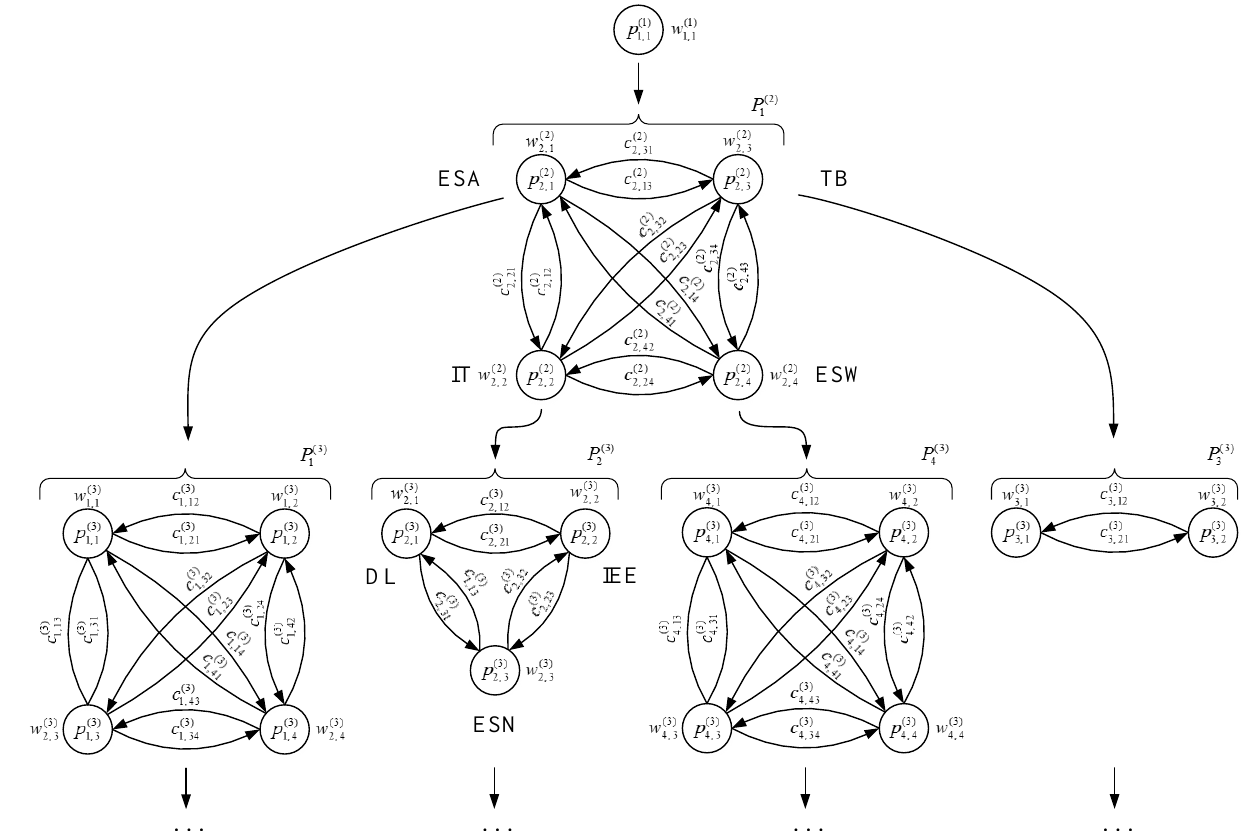
Figure 1 – The hierarchical structure of indicators for the education quality in